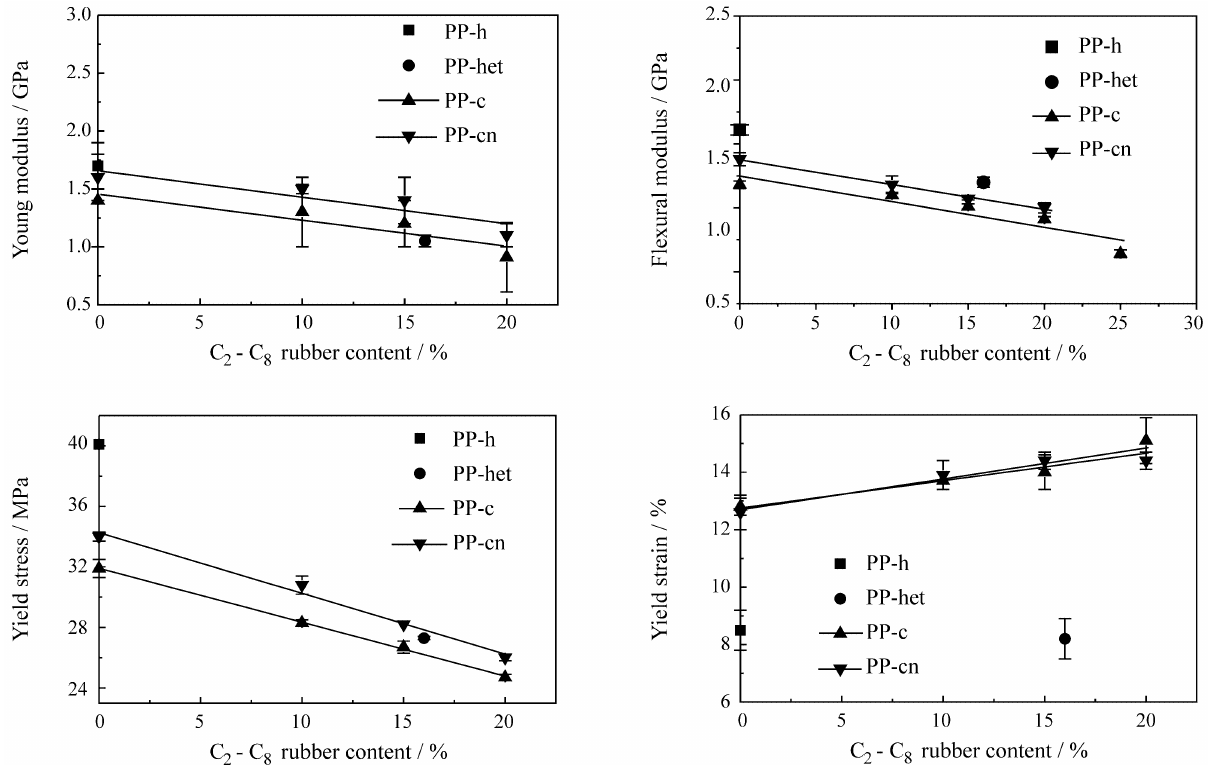
Figure 2. Young modulus, flexural modulus, yield stress and yield strain, as a function of C 2 -C 8 elastomer content in the blends, all measured at room